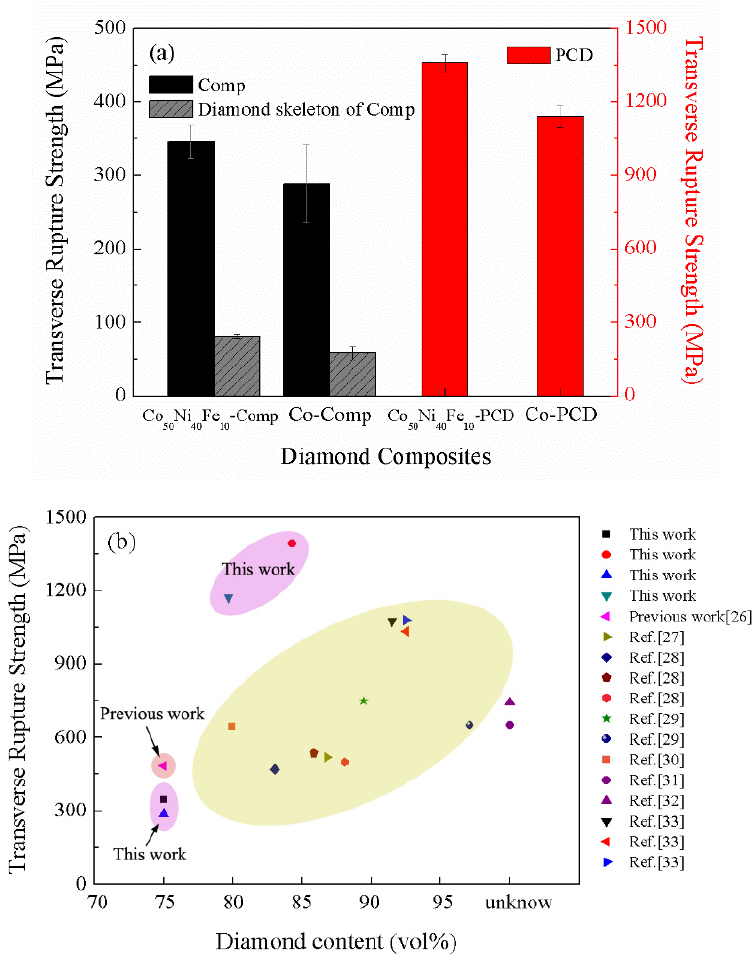
Figure 6. ( a ) Transverse rupture strength of diamond composites, diamond skeleton and PCD; ( b ) Comparison of transverse rupture strength of PCD with different diamond contents in references